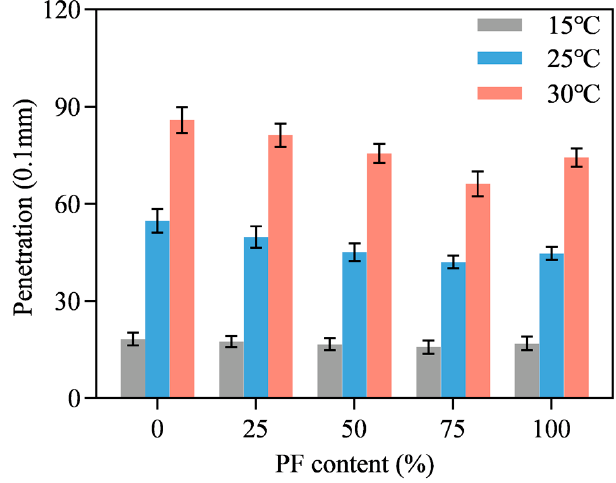
Figure 7. Filler-asphalt ratio of 0.8.